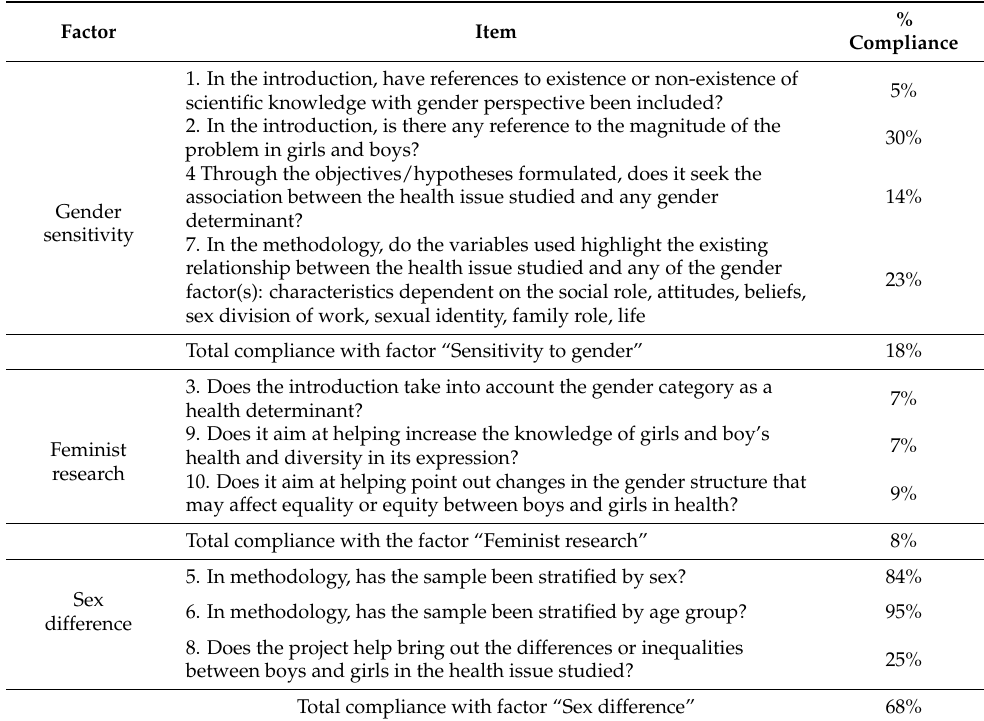
Table 2. Percentage of compliance with GPIHR